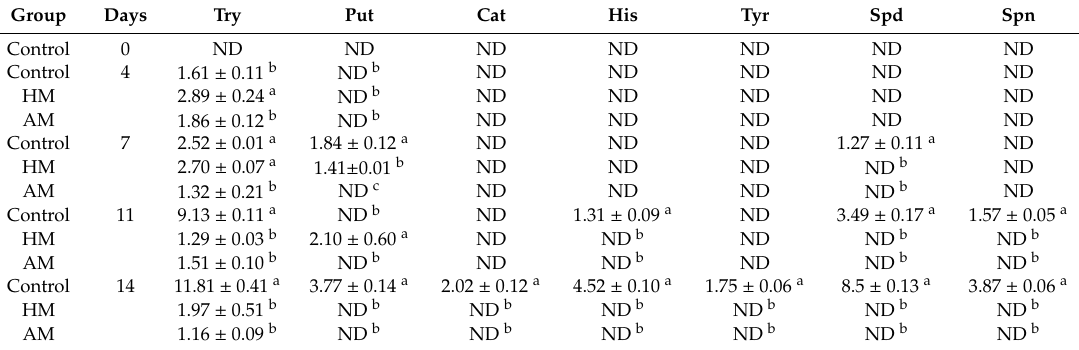
Table 2. Biogenic amine content (mg / 100 g muscle) of Penaeus monodon treated with Hypnea musciformis (HM) and Acanthopora muscoides (AM) during storage at 0 ◦ C for 14 days. Group